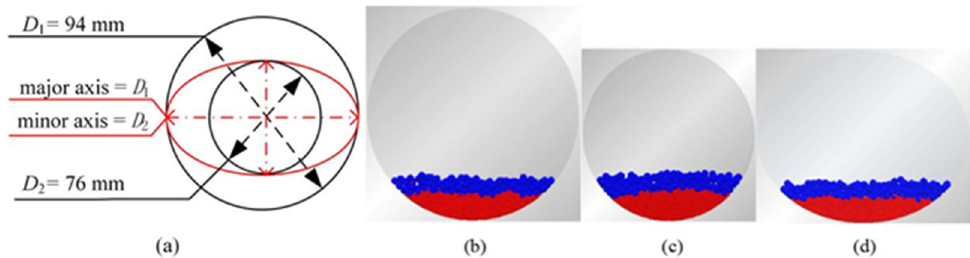
Figure 1. Three different rotating drums and initial states of binary particles in rotating drums. ( a ) Cross-sectional shapes of three different rotating drums; ( b ) the initial particle bed in the circular drum, D 1 = 94 mm; ( c ) the initial particle bed in the circular drum, D 2 = 76 mm; ( d ) the initial particle bed in the elliptical rotating